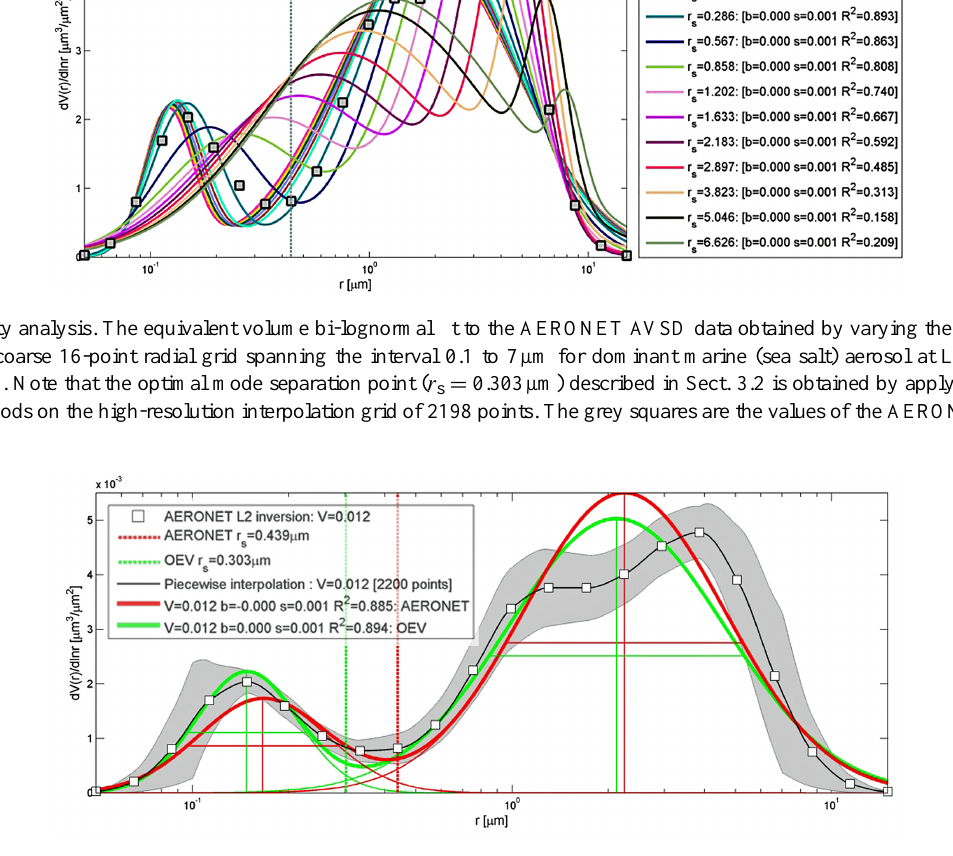
Fig. 3. Comparison of the interpolated AVSD for dominant marine (sea salt) aerosol at Lanai, Hawaii, on 21 January 2002 with the AERONET bi-lognormal fit and the optimized equivalent volume (OEV) fit. The grey band is the uncertainty on the AERONET